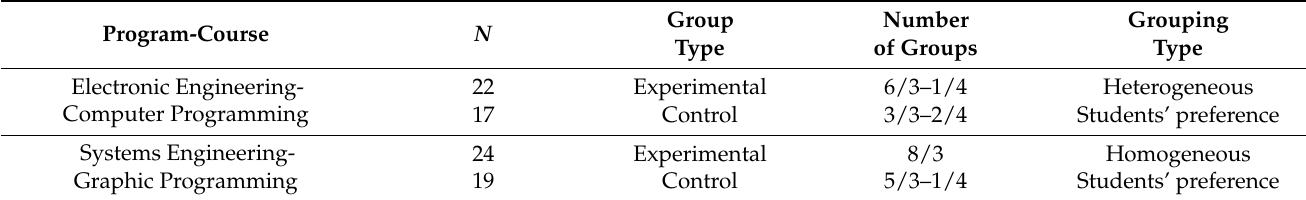
Table 11. Characterization of the working